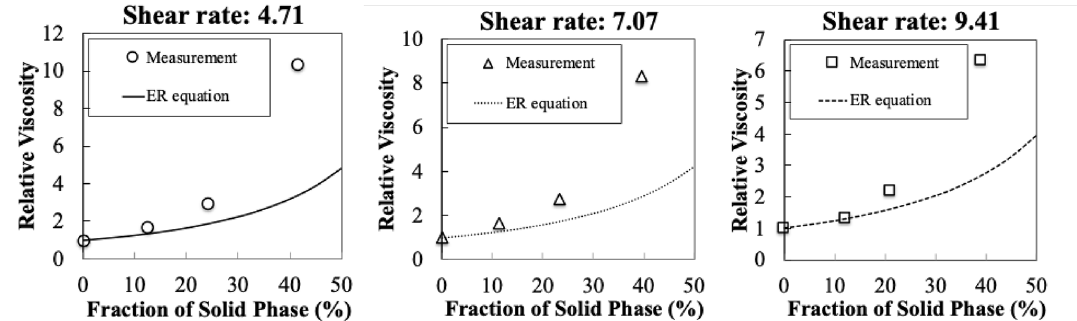
Figure 1. Underestimation results of the viscosity by an Einstein–Roscoe equation. The measurements are obtained in a matrix of CaO − Al 2 O 3 − SiO 2 − MgO slag at 1773 K. Each plot corresponds to a different shear rate. The details regarding the experimental system is described in the “Methods”